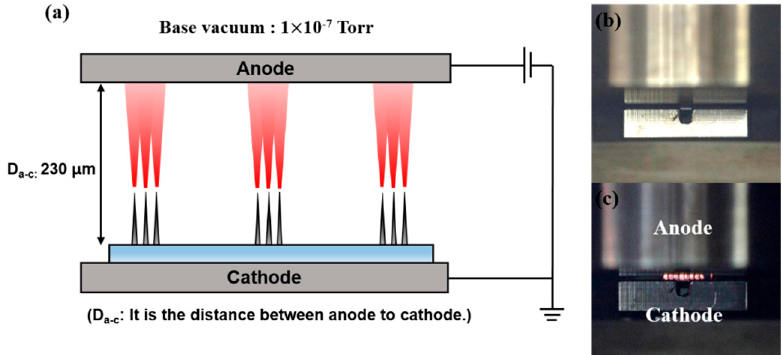
Figure 2. Diode system for measuring current-voltage (I-V) characteristics. ( a ) Schematic diagram of diode system; ( b ) digital single lens reflex camera image of the diode system; ( c ) observed Joule heating when the electron emission current is higher.